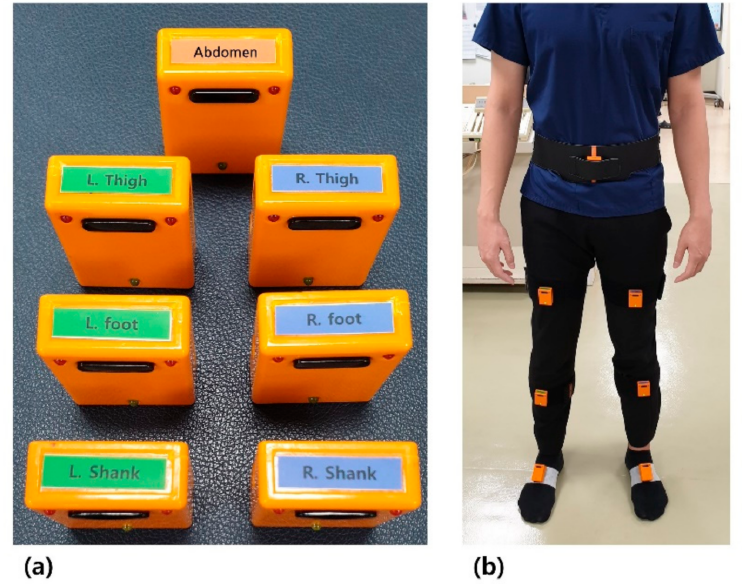
Figure 1. ( a ) The IMU sensors used in gait-analysis system; ( b ) The IMU sensors placed on the. dorsum of both feet, the shafts of both tibias, the middle of both femurs, and the lower abdomen. After acquiring the gait parameters, hip-knee cyclograms were obtained by simul- taneously plotting the hip and knee joint angles on one plane throughout the entire gait cycle [12,25]. The hip–knee cyclograms used in this study were plotted in a clockwise direction, from the stance phase, which was calculated from the heel strike point to the toe-off point and to the swing phase, which was calculated from the toe-off point to the heel strike point, as described previously [14]. Then, we obtained the average value of hip-knee cyclogram parameters including the range of motion (ROM) of the hip and knee joint angles, perimeters, and areas. A representative hip-knee cyclogram used in this study is shown in Figure